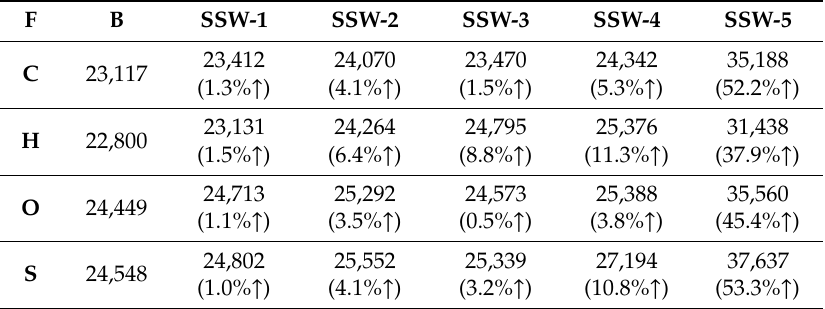
Table A2. Travel distance from residents in St. Lawrence Parish to destinations.